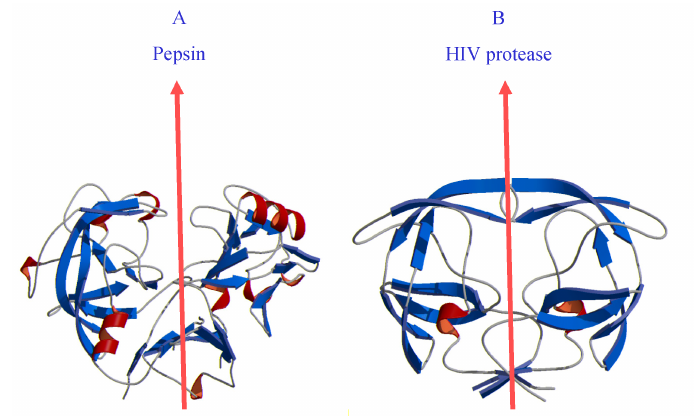
Figure 4. Evolution of pepsin family of aspartic proteases from an ancestral dimeric protease. ( A ) Pepsin and other aspartic proteases are monomers with a pseudo 2-fold axis, shown by the red arrow above, relating the two halves of the enzyme, each with the Asp-Thr-Gly motif, and suggesting a dimeric ancestor [27]. ( B ) A modern day retroviral protease such as HIV protease has a 2-fold axis, shown by the red arrow above, resembles the predicted dimeric enzyme, as first suggested by Toh et al., 1985 [33], and confirmed experimentally by several groups experimentally to exist to the present day in viral proteases [34–39].